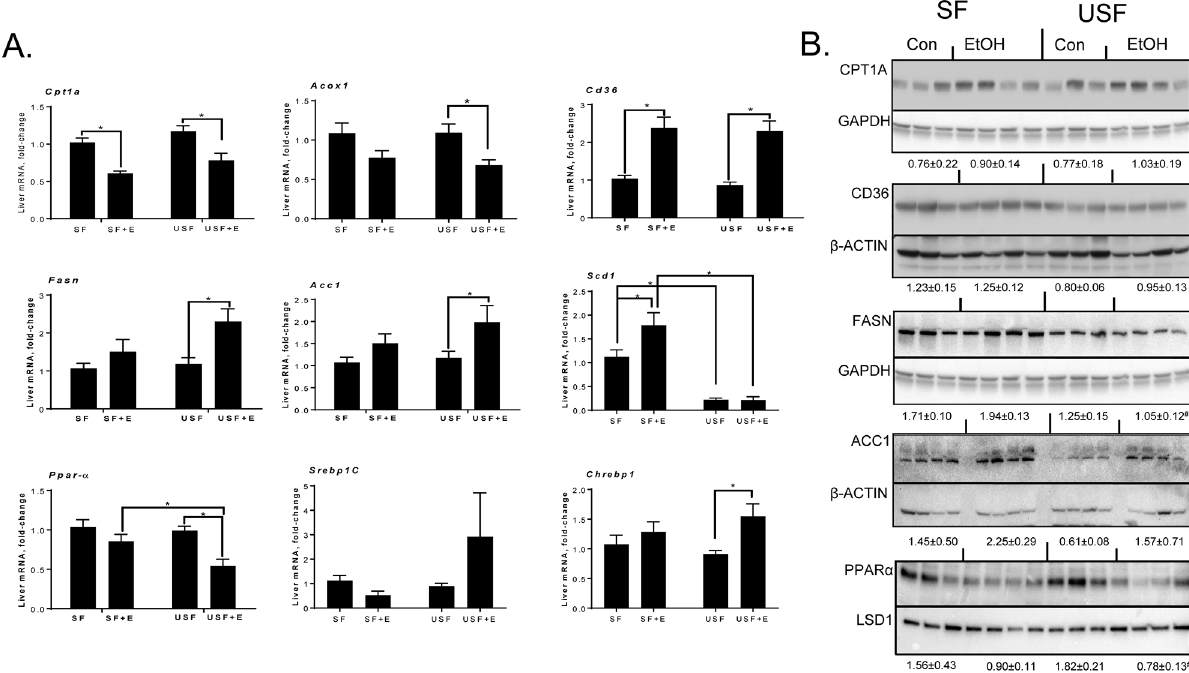
Fig 2. Alterations in the regulation of lipid metabolism in mice fed SF or USF following EtOH administration. Gene (panel A) and protein (panel B) expression of key enzymes and transcription factors involved in the regulation of lipid homeostasis. qPCR data are expressed as the fold-change relative to the SF pair-fed group (mean ± SEM, n = 8–10). Western blots were quantified using Image J and normalized to the respective loading controls and presented below each group (mean ± SEM, n = 3–4). (cid:3) P < 0.05, two-way ANOVA; # P < 0.05 vs. control; ## P < 0.05 vs. SF+EtOH; E, ethanol; SF, saturated fat; USF, unsaturated